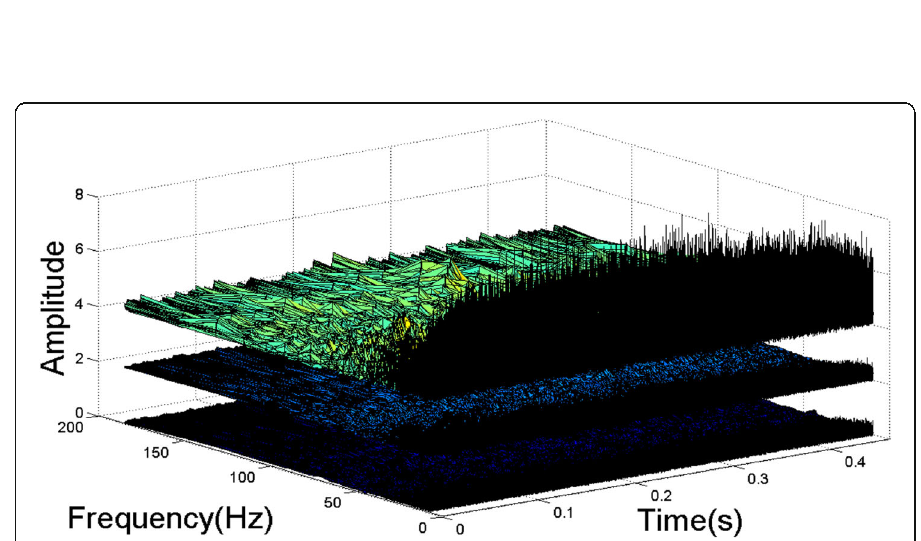
Fig. 16 Time-frequency diagrams of 3 vibration signals under fault state